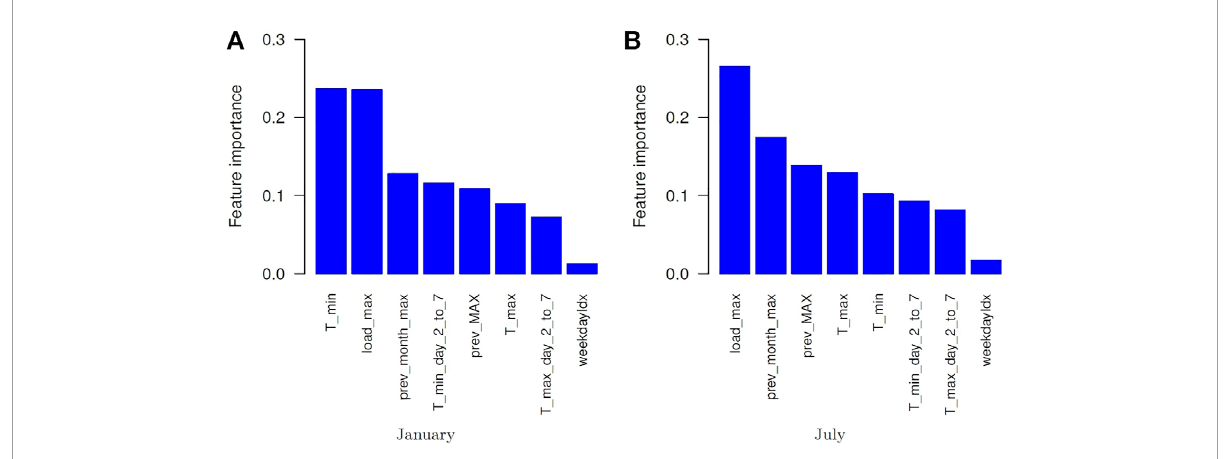
FIGURE 5 Feature importance of peak day models for (A) January and (B) July.